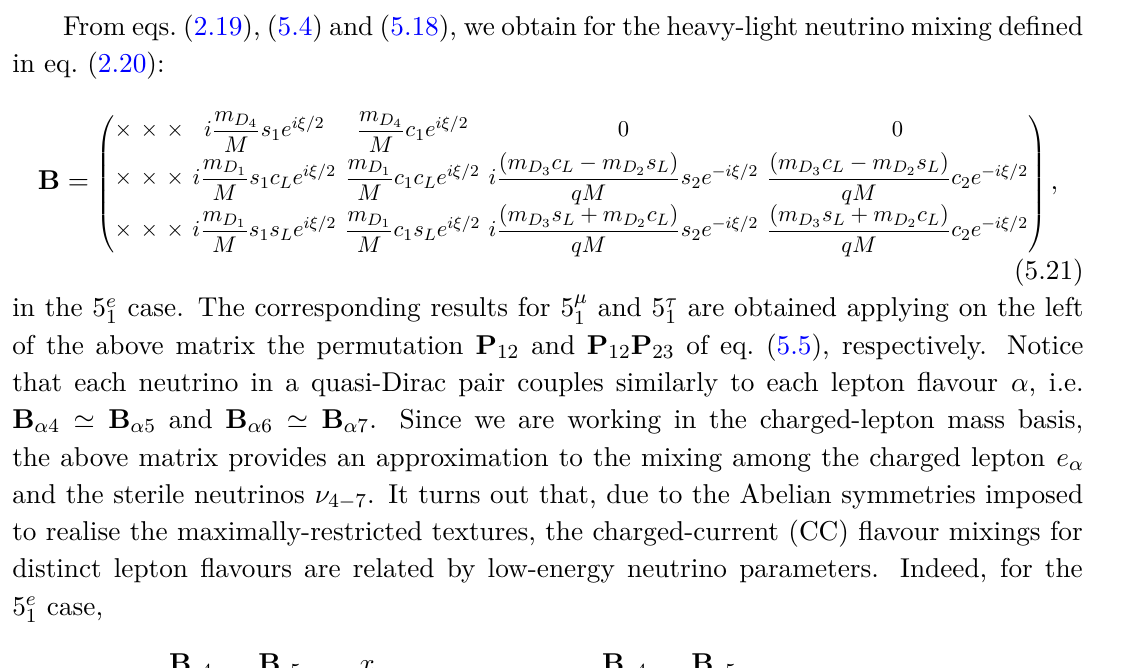
and IO cases. e,µ,τ e,µ,τ